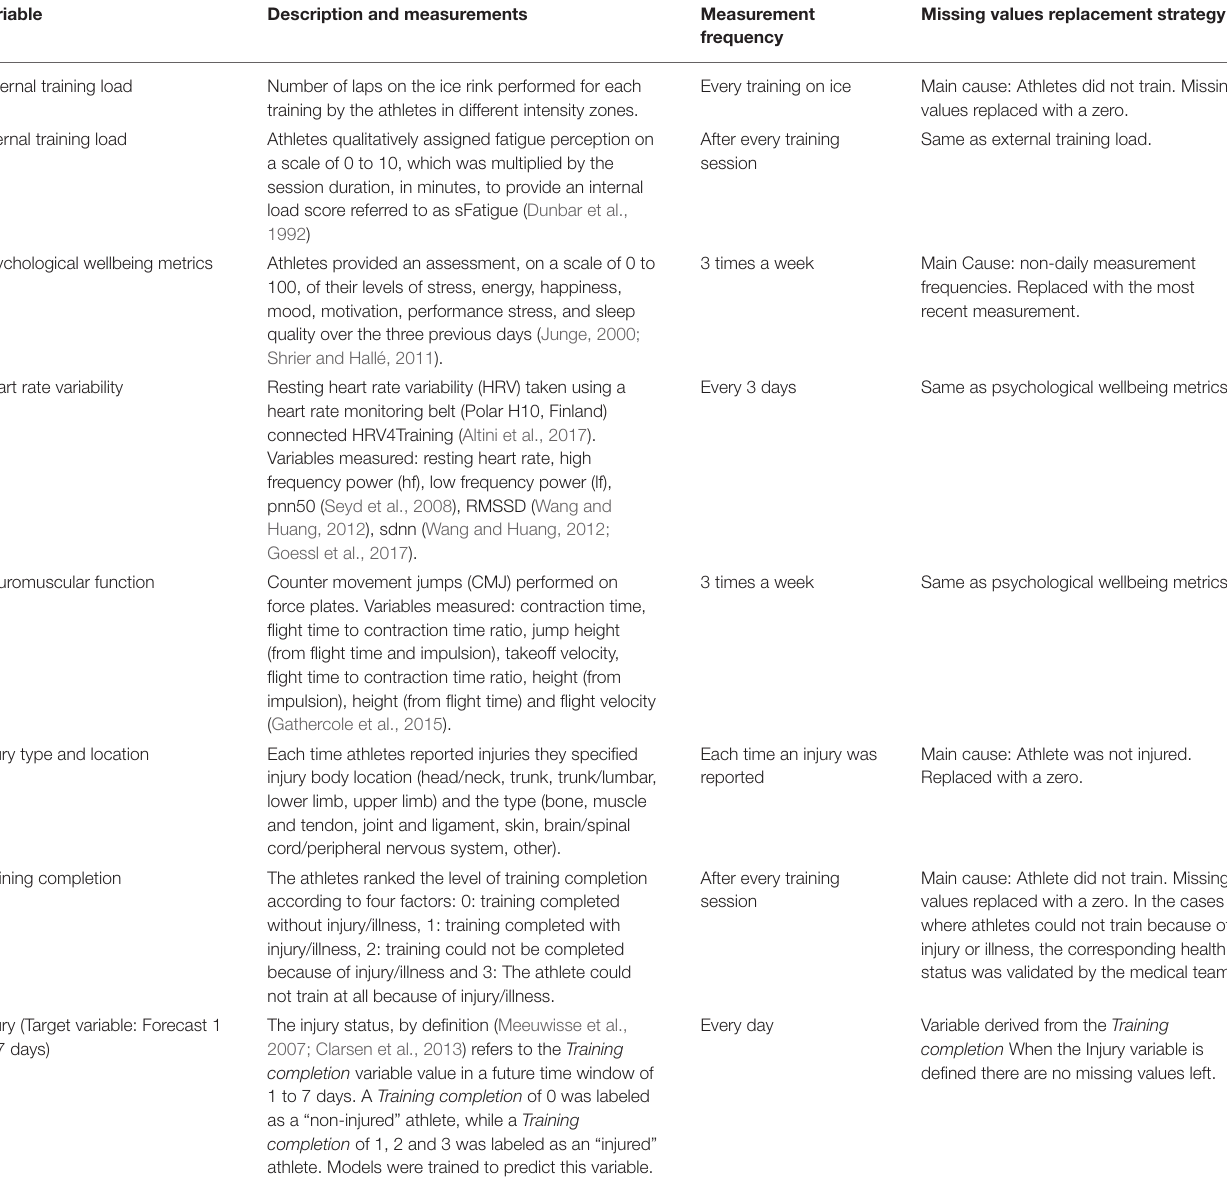
TABLE 2 | Description of the different variables, their measurement frequency, and the strategies used to replace missing values. Variable Description and measurements Measurement Missing values replacement strategy frequency Number of laps on the ice rink performed for each Every training on ice Main cause: Athletes did not train. Missing training by the athletes in different intensity zones. values replaced with a